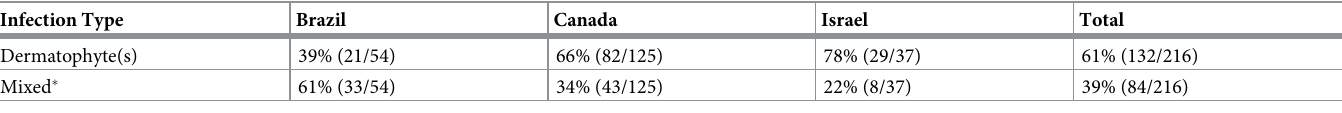
Table 1. Infection type in global onychomycosis by country.